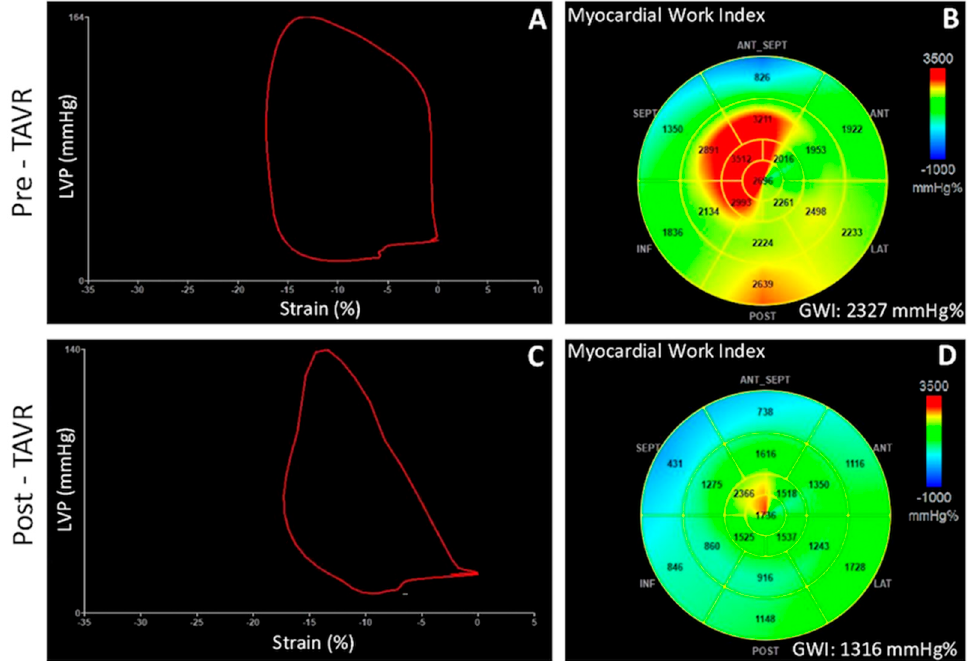
Figure 4. Pressure-strain loop ( A , C) and 17-segment bull’s-eye representation of global work index ( B , D ) in a patient with severe aortic stenosis before and after transcatheter aortic valve implantation, demonstrating a significant reduction of stroke work, and therefore GWI, as a consequence of the reduced afterload post valve replacement. GWI = global work index; LVP = left ventricular pressure; TAVR = transcatheter aortic valve replacement.